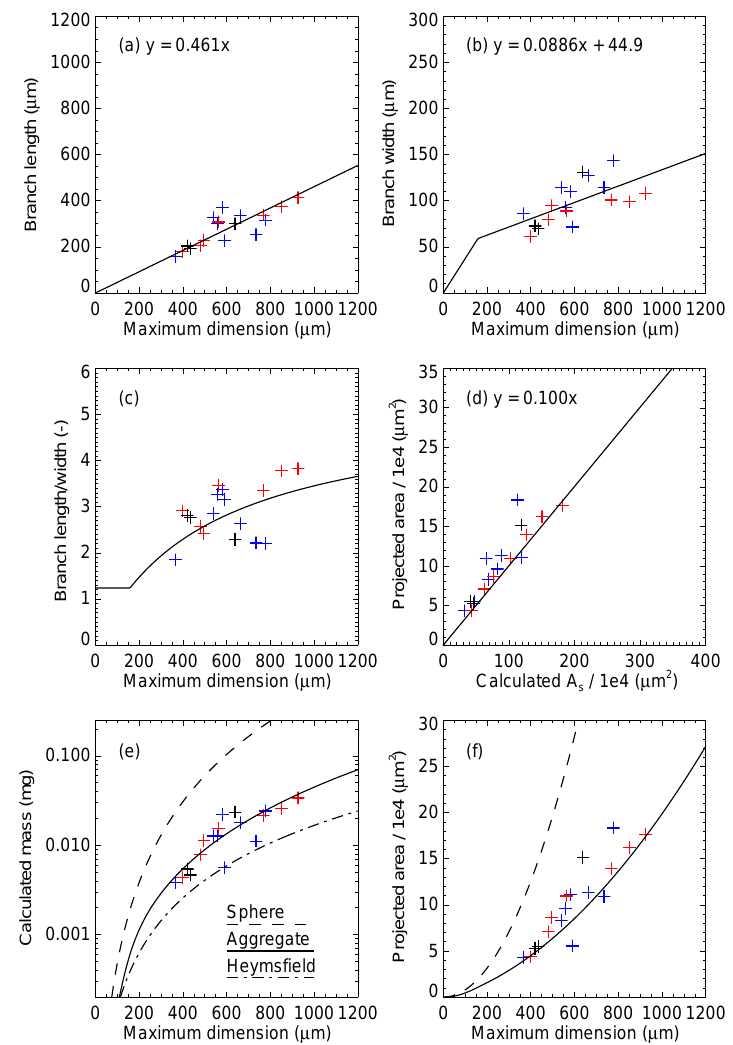
Figure 9. Aggregate model: measured and calculated properties of aggregates of bullet rosettes with 12 arms (black symbols), fewer than 12 arms (blue symbols), and more than 12 arms (red symbols). Line types indicate derived ice properties as follows (see legend in panel e ): a sphere, a 12-arm bullet rosette aggregate (see Sect. 4.3 and Appendix A3), and aggregates of bullet rosettes from Heymsfield et al.